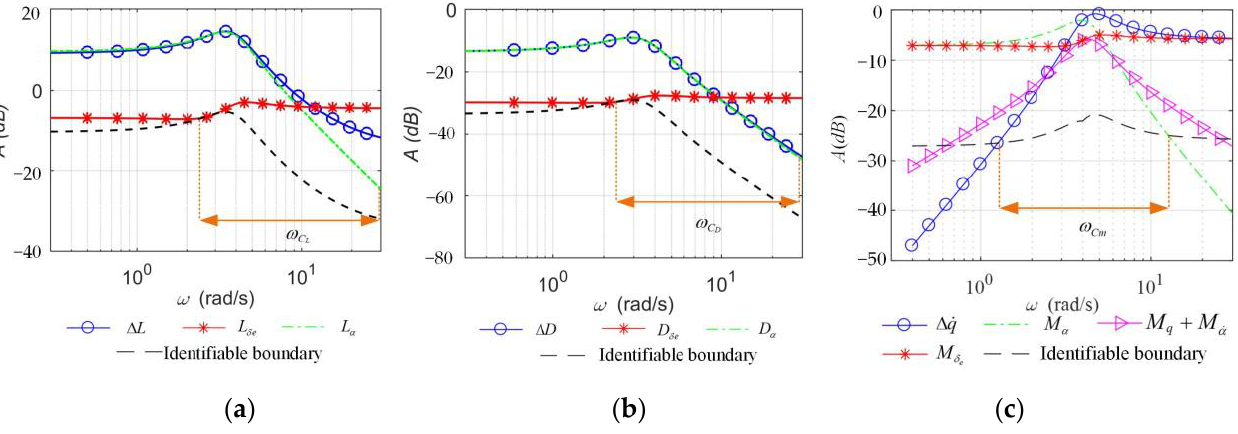
Figure 10. Amplitude–frequency characteristic curve of aerodynamic parameters with the frequency of the excitation signal: ( a ) lift; ( b ) drag; ( c ) pitch moment. The pitch moment Bode diagram contains | M α ( ω )/ δ e |, | M q + M . α ( ω )/ δ e |, | M δ e ( ω )/ δ e |, | M . q ( ω )/ δ e | curves, as shown in Figure 10a; the lift Bode diagram contains | L α ( ω )/ δ e |, | L δ e ( ω )/ δ e |, and | ∆ L ( ω )/ δ e | curves, as shown in Figure 10b; and the drag Bode diagram